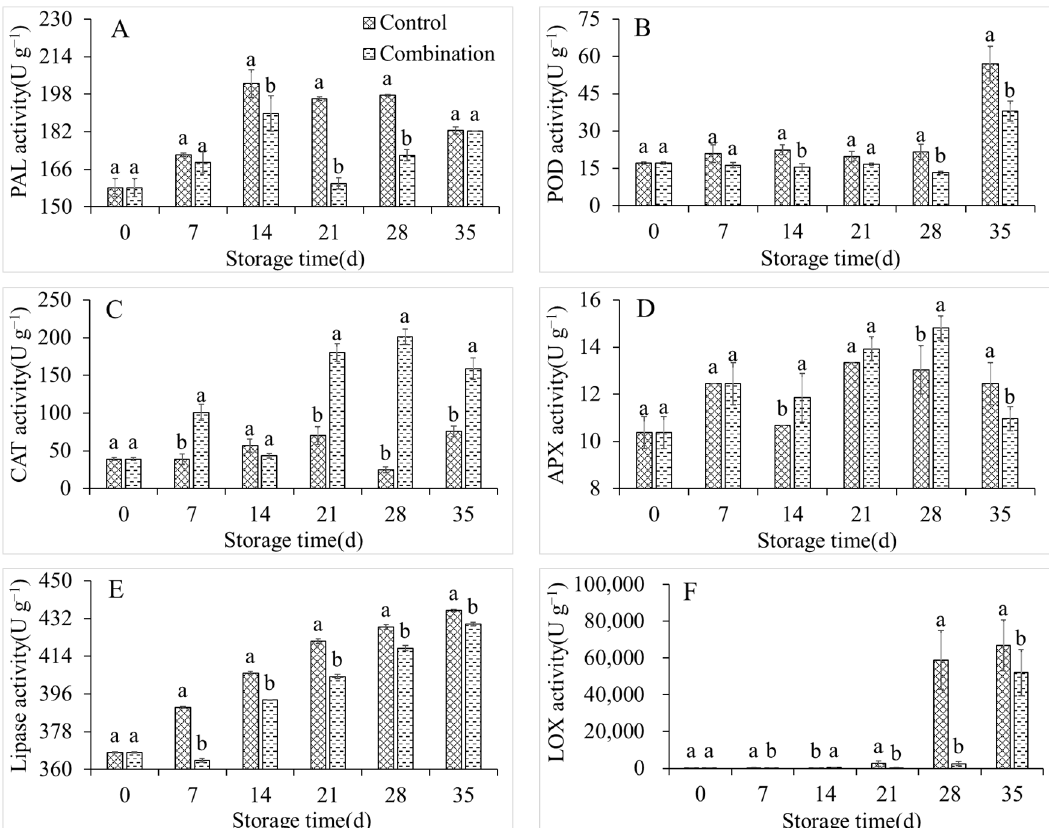
Figure 4. PAL ( A ), POD ( B ), CAT ( C ), APX ( D ), lipase ( E ), and LOX ( F ) activities of peaches during storage at 5 ◦ C. Vertical bars indicate the standard errors of three replications. Different lowercase letters at same storage time points are significantly different ( p <